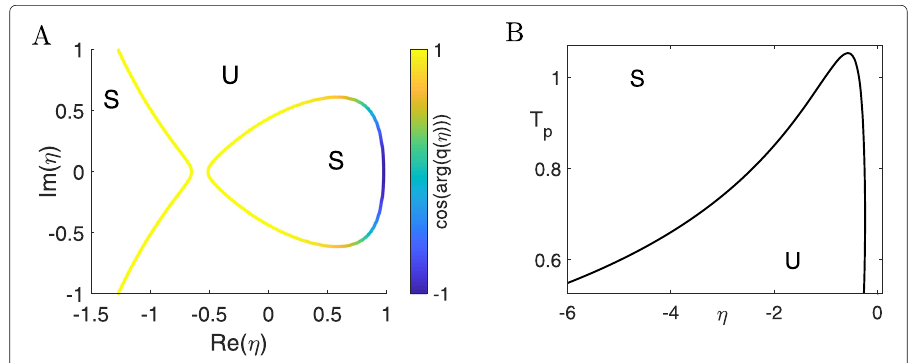
Fig. 3 a Zero-contours of the MSF for luminal coupling and T p = 0.9. The MSF is negative in regions denoted by S and positive in regions labeled U. The colour represents the value of cos ( arg ( q (η))) . b Zero values of the MSF for real values of η as pacing periods